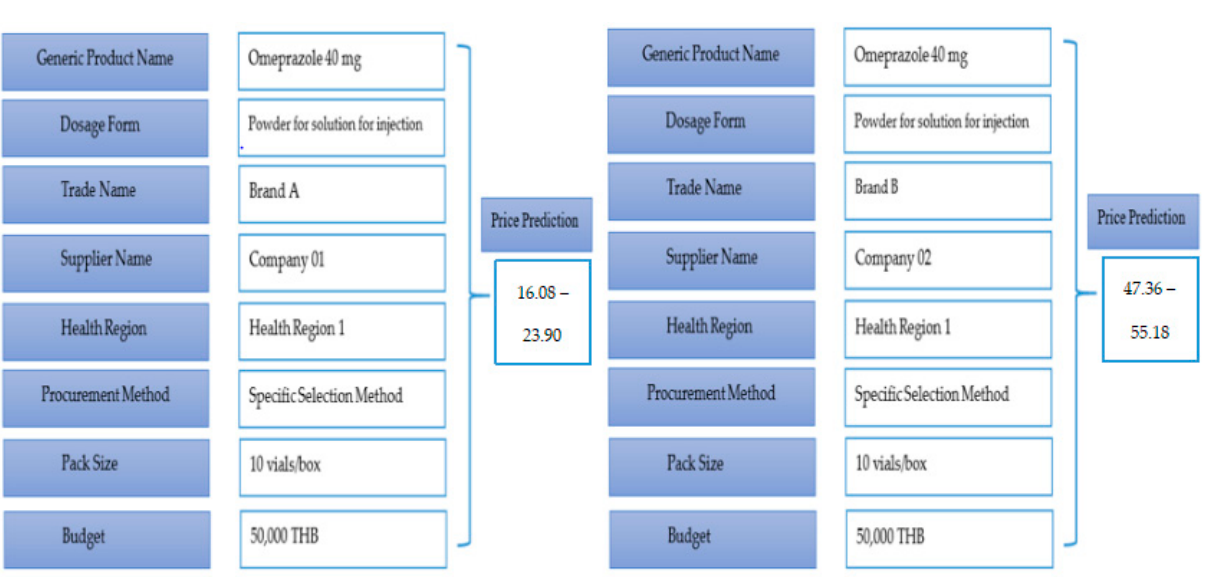
Table 3. Performance evaluation results.